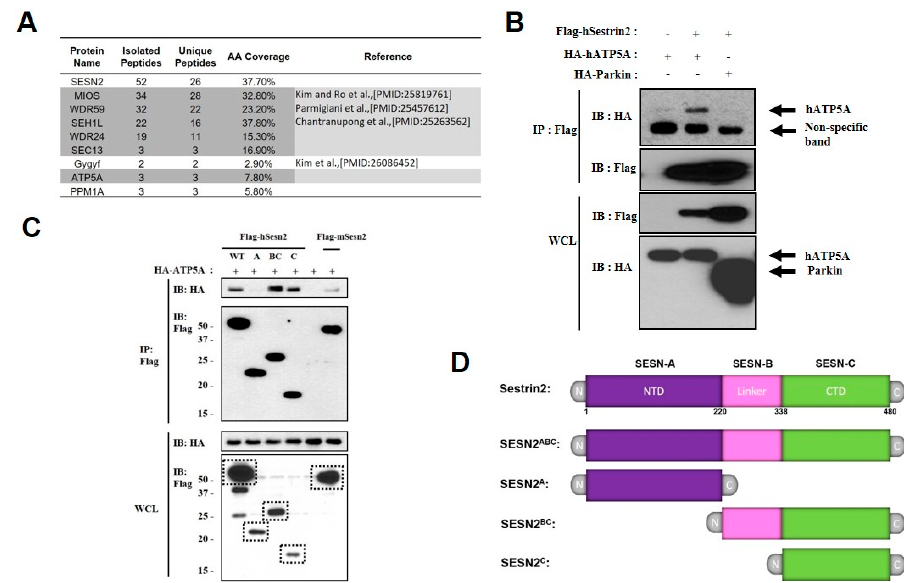
Figure 1. Mitochondrial protein ATP5A interacts with Sestrin2 through C-terminal domain of Sestrin2. ( A ) Mass spectrometry (MS) analysis of Sestrin2-tandem affinity purification (TAP) products ( A ) Mass spectrometry (MS) analysis of Sestrin2-tandem a ffi nity purification (TAP) products identified mitochondrial protein ATP5A (gene name: atp5a1, ATP synthase alpha subunit 1) as proteins that show the strong physical association with Sestrin2. Sestrin2 TAP products from human mammary epithelial cells (MCF-10A) were analyzed by MS-MS. The number of peptide hits for Sestrin2 and partners (shaded in gray). ( B ) ATP5A is associating with Sestrin2 in mammalian cells. HEK293 cells